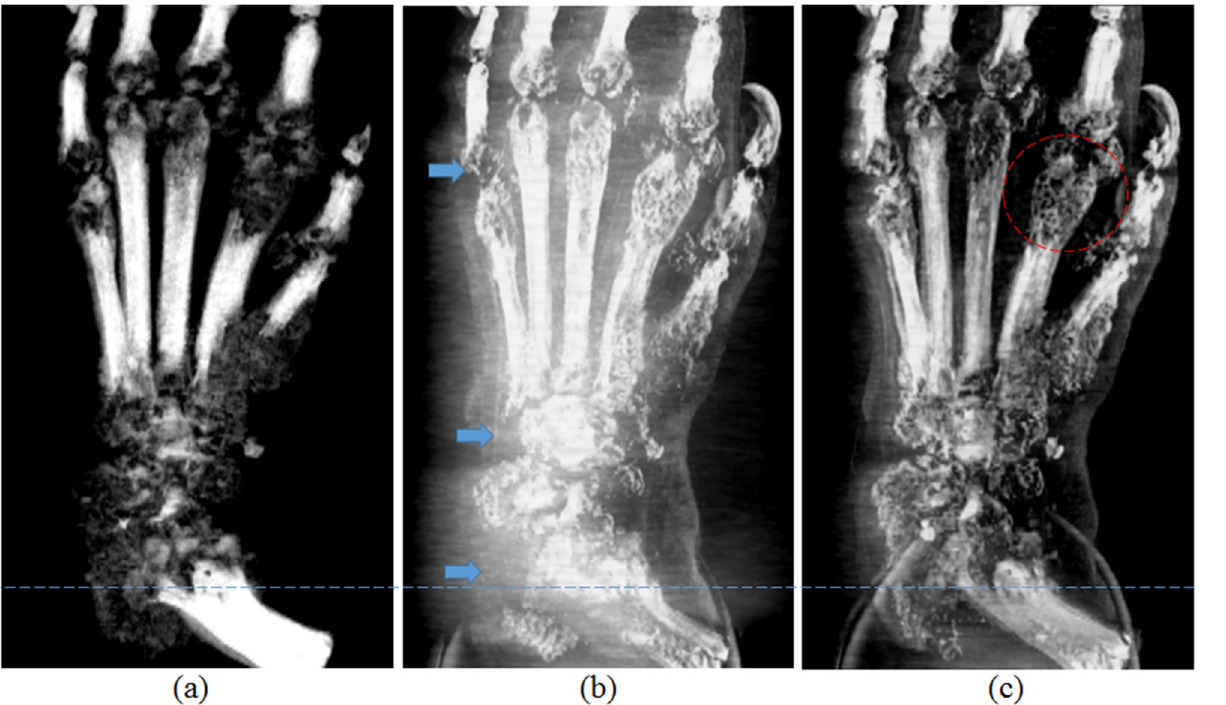
Fig 9. MIP images from a rat model of human rheumatoid arthritis. Absorption (a), phase contrast with bone artefact (b), and phase contrast using the proposed algorithm (c).